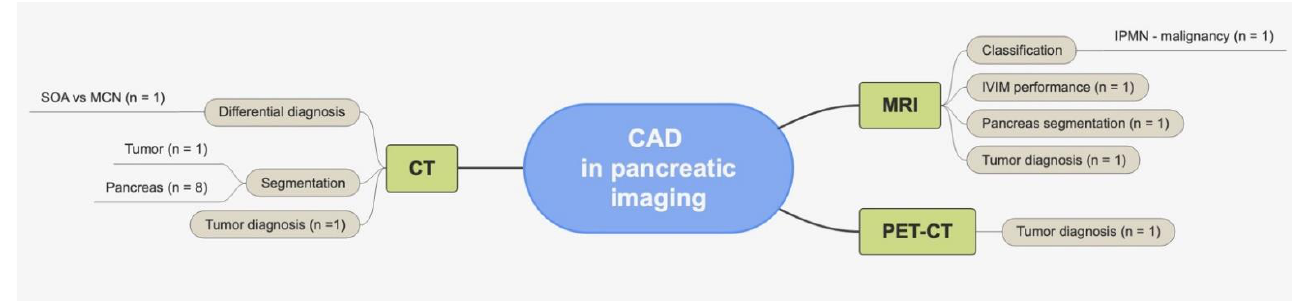
Figure 3. Summary of CAD applications in pancreatic imaging.